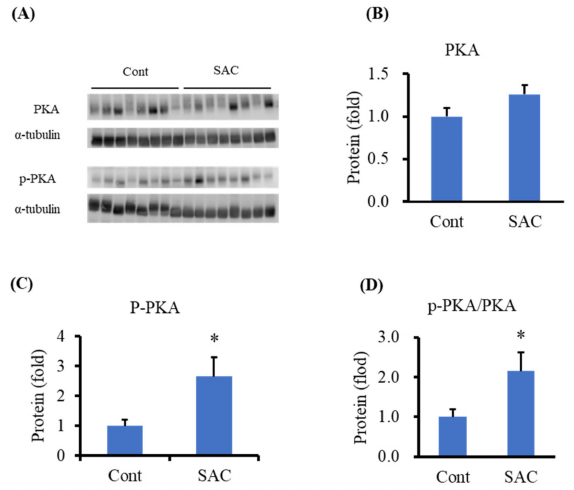
Figure 3. SAC activates protein kinase A (PKA) in the testes of mice. ( A ) Western blot image of protein expression of PKA and phosphorylated PKA (p-PKA) in the testis. ( B – D ) Quantification of protein expression of PKA, p-PKA, and p-PKA/PKA. Data are presented as the mean ± SE ( n = 8). Data were analyzed by Student’s t -test. * p < 0.05 compared to the control